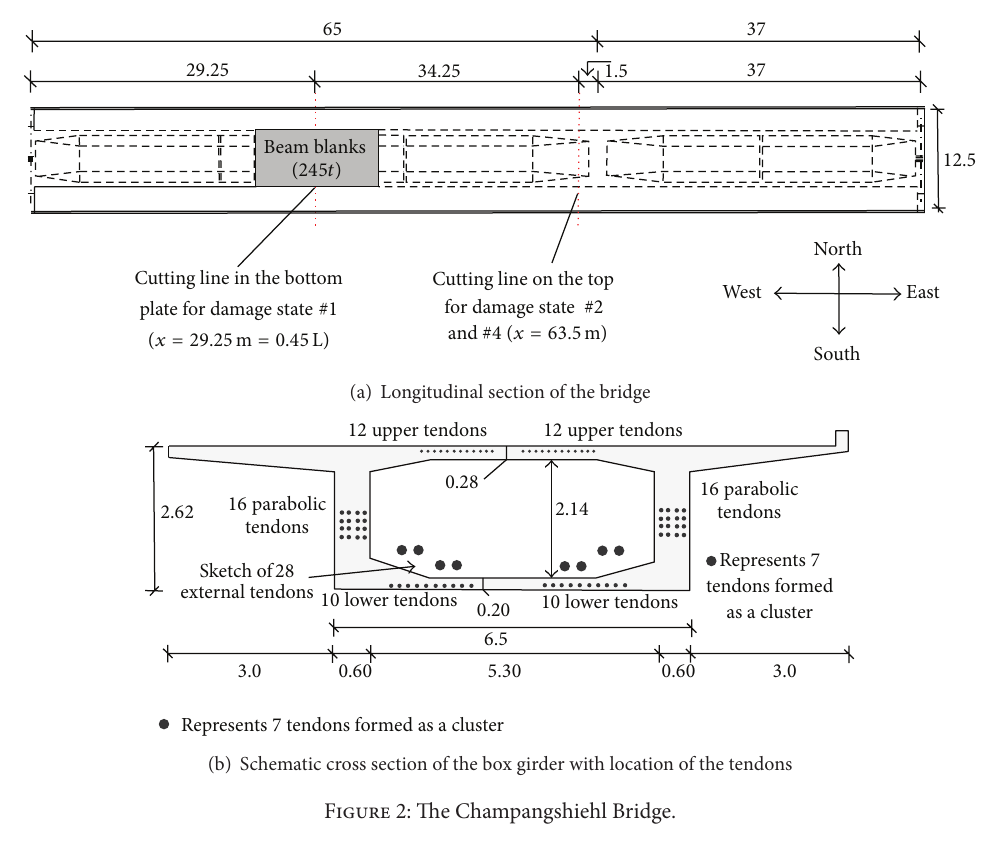
Figure 2: The Champangshiehl Bridge.